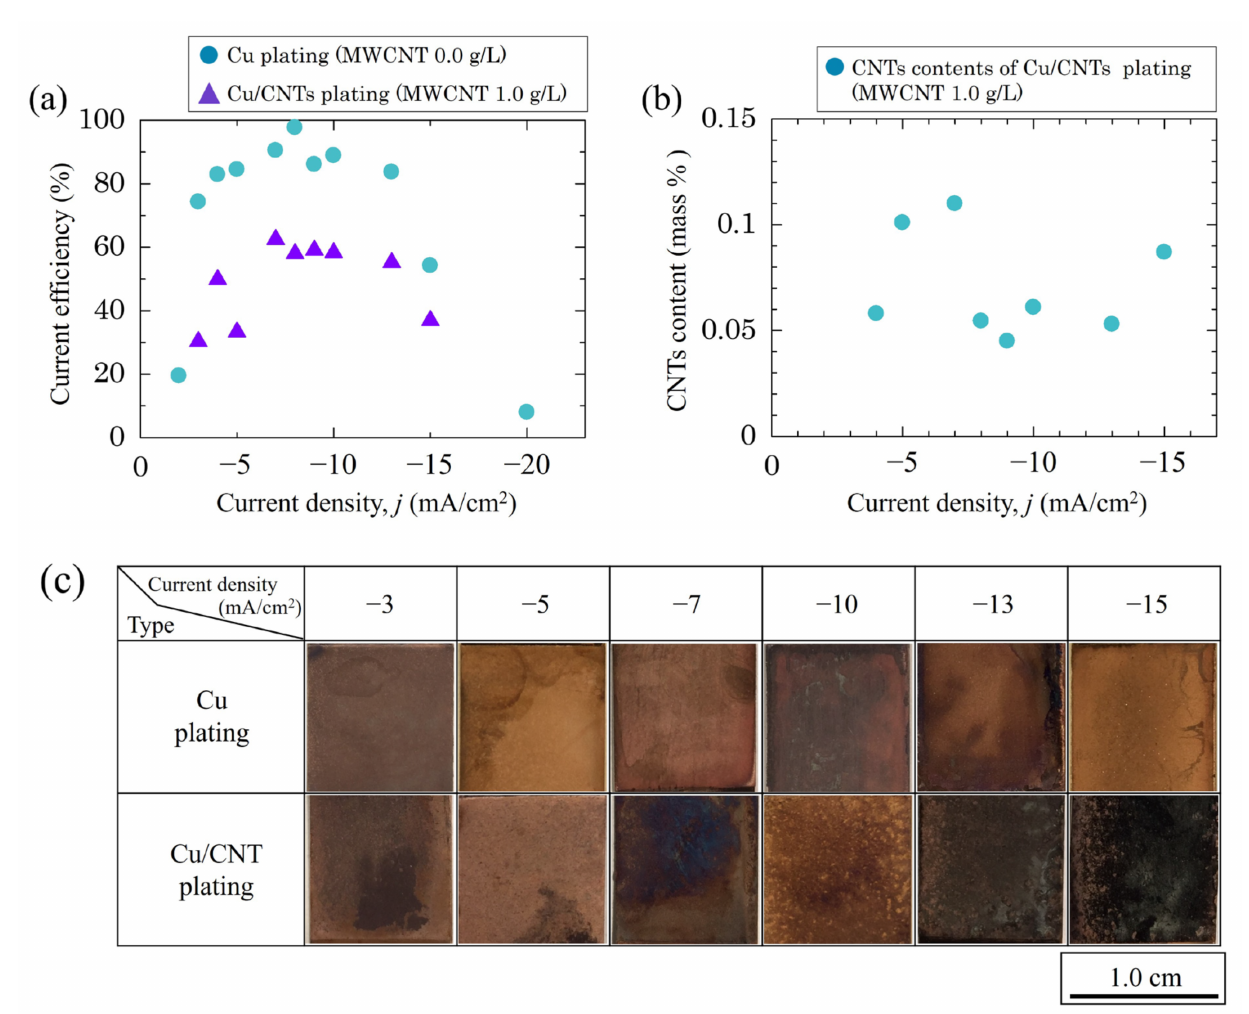
Figure 5. ( a ) Current efficiency of Cu and Cu/CNT plating; ( b ) CNT content of Cu/CNT